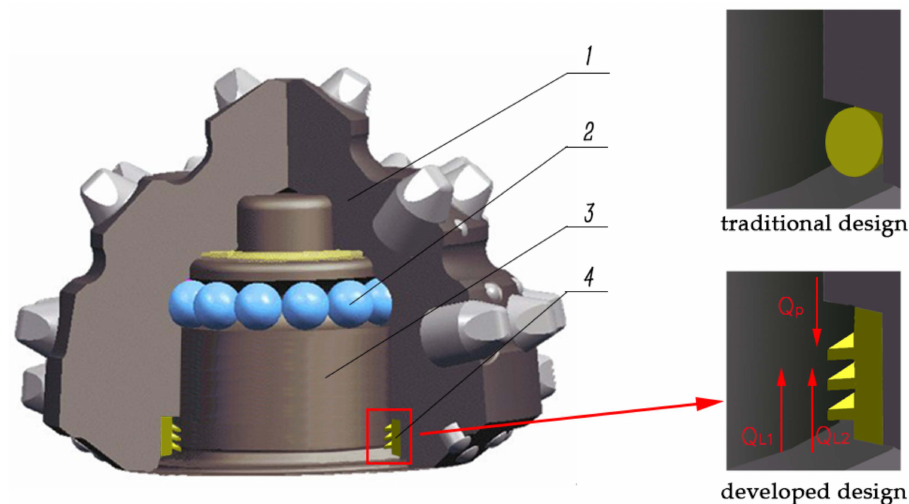
Figure 1. Helical seal structure.1. Cone; 2. steel ball; 3. bearing; 4. spiral